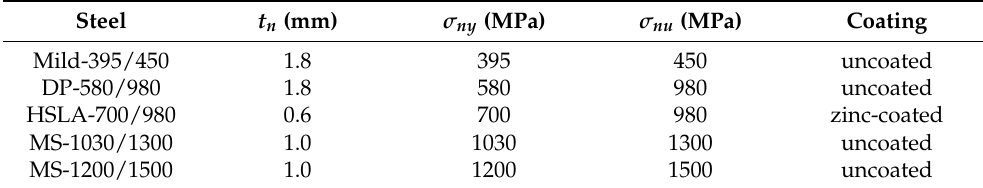
Table 2. Nominal properties and coating of the steel